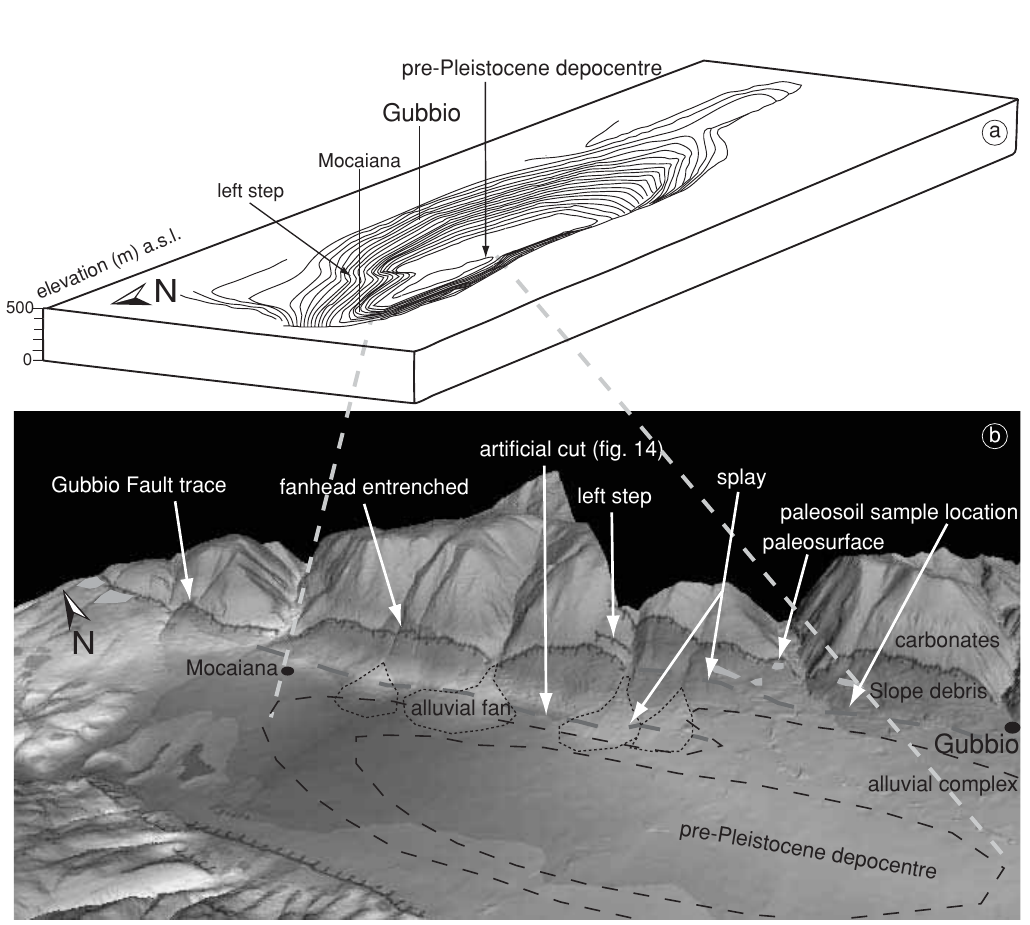
Fig. 3a,b. a) 3D reconstruction of the pre-Pleistocene basement (after Menichetti, 1992, redrawn); b) 3D view of the northeastern side of the Gubbio Basin derived by 5-m resolution DEM. Hypothesized Gubbio Fault splays are reported along with to the location of the northern part of the pre-Pleistocene depocentre suggested by Menichetti